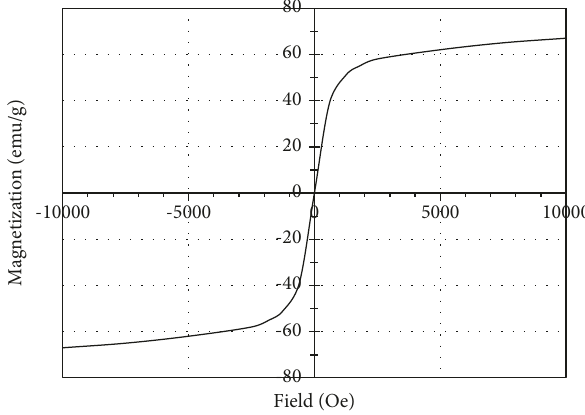
Figure 6: Magnetization curve of magnetite.